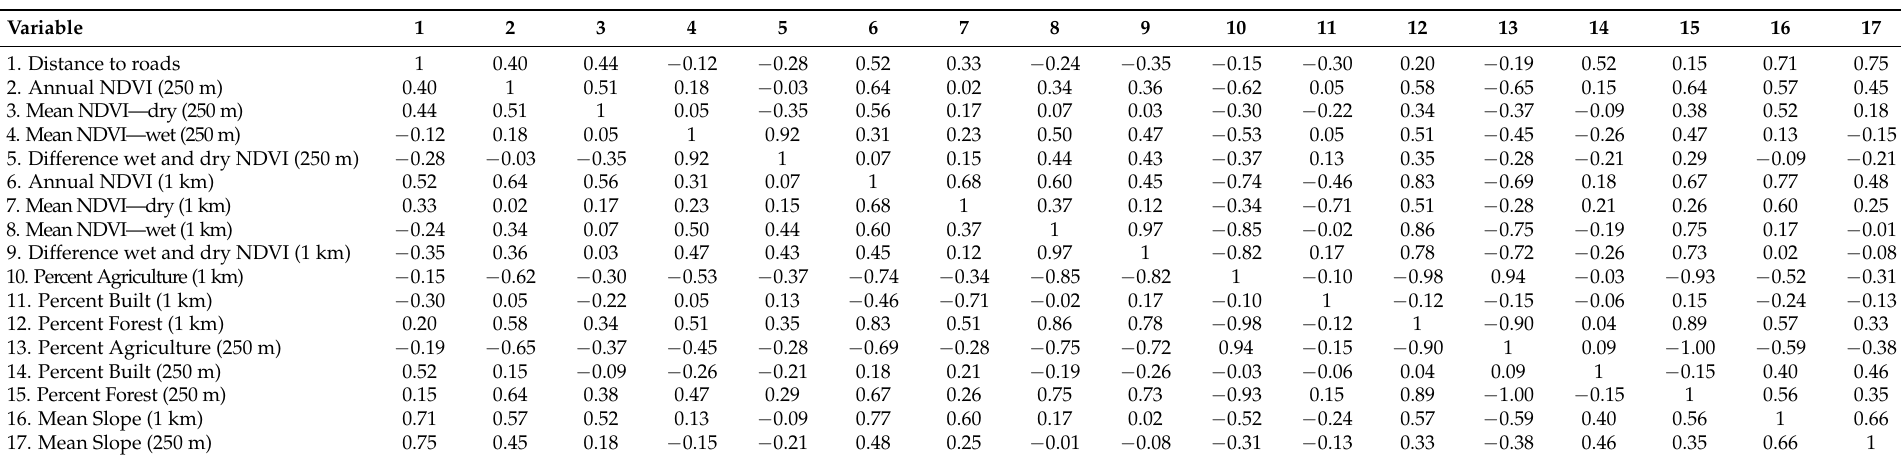
Table A2. Correlation of all analyzed model